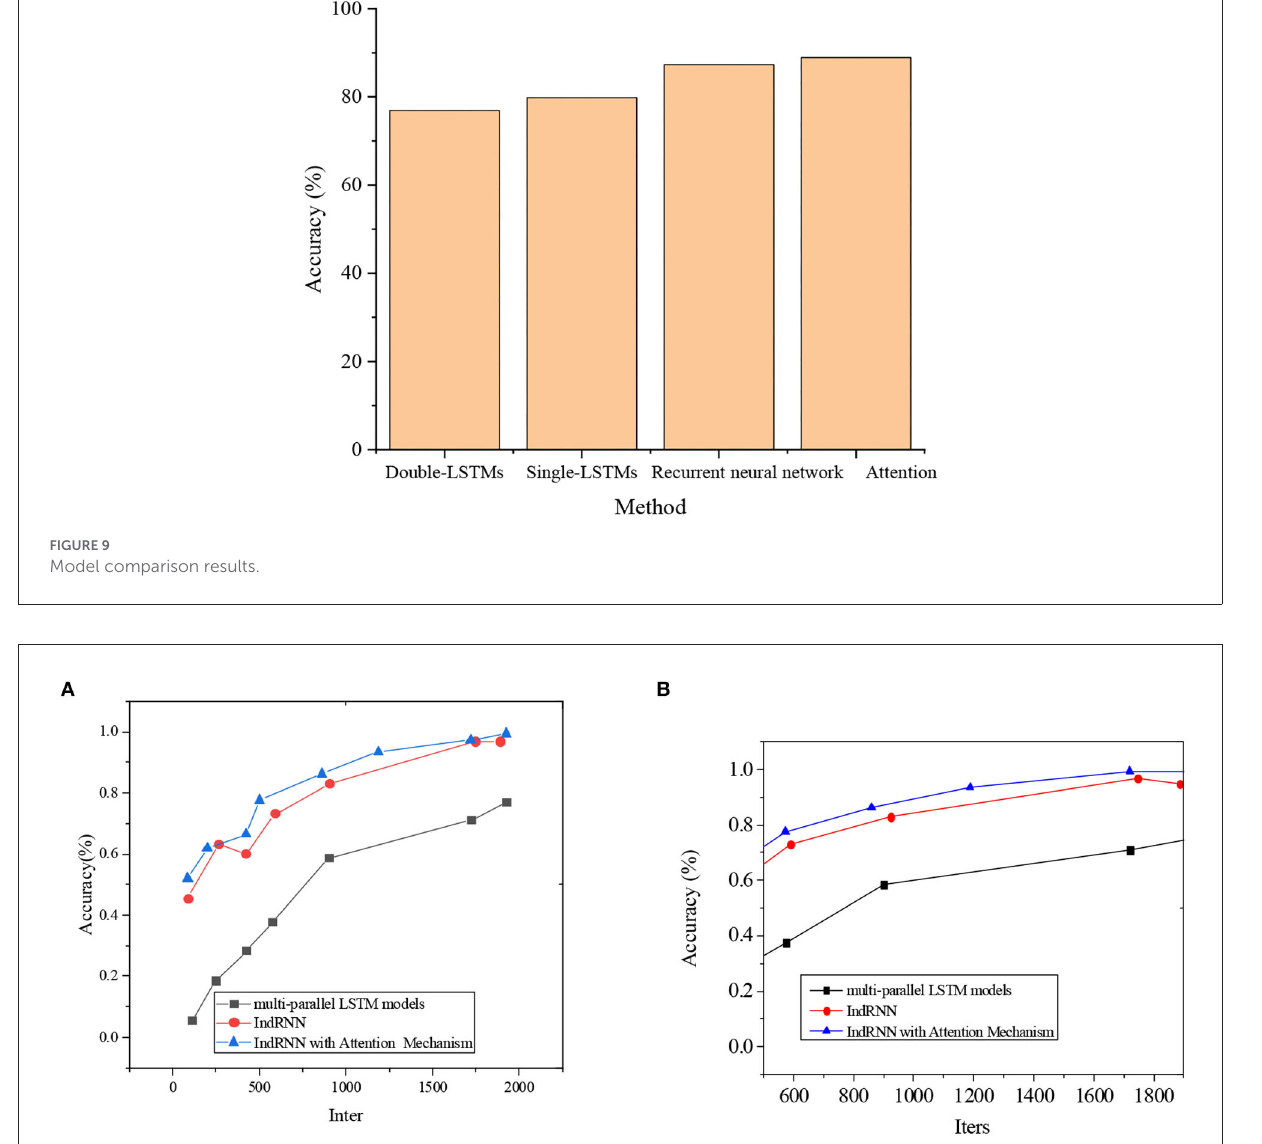
FIGURE10 Comparison of multi-parallel LSTM models, IndRNN, and AM-IndRNN. (A) the first test; (B) the second